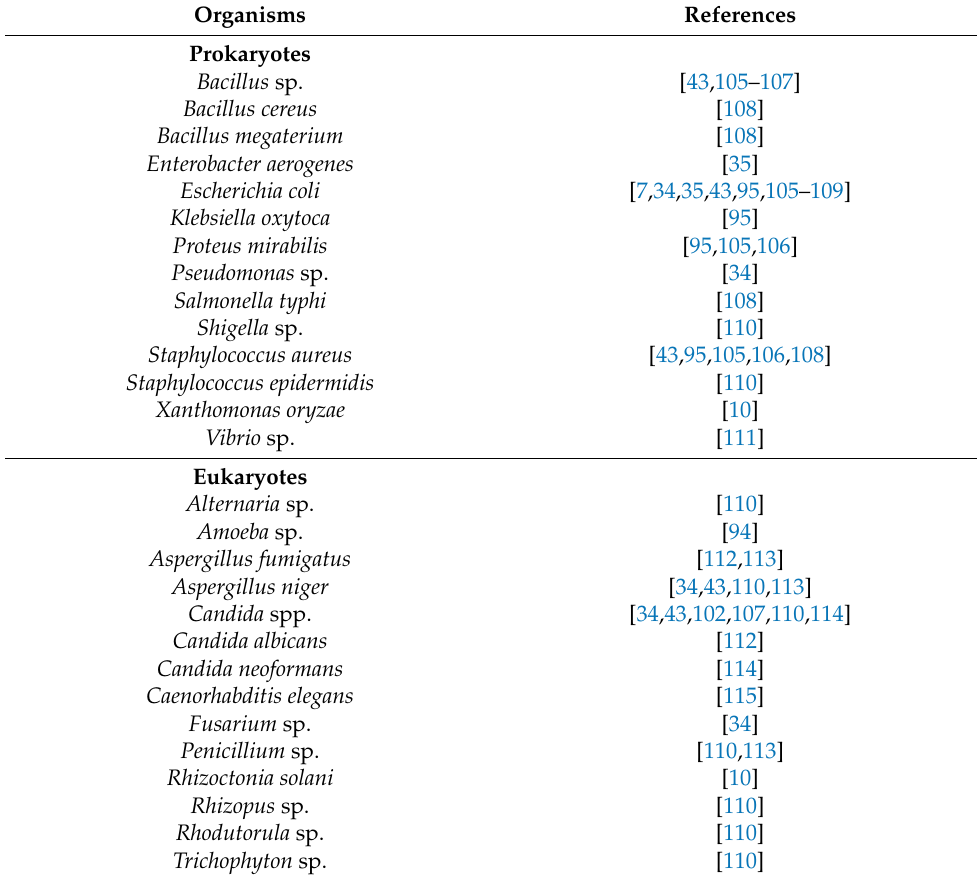
Table 1. Summary of some susceptible organisms to